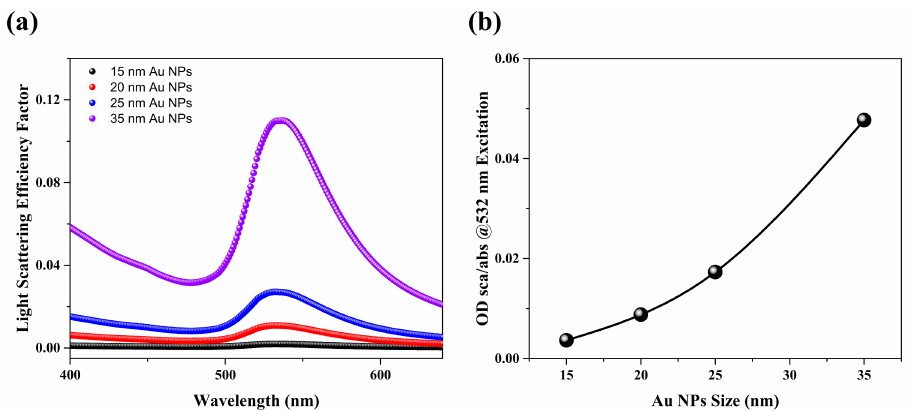
Figure 5. ( a ) Simulation plot for light scattering efficiency as a function of the size, obtained by NANODDSCAT+. ( b ) Ratio of scattering to absorption (ODsca/abs) at the plasmon excitation wavelength. The solid line in figure ( b ) is a visual